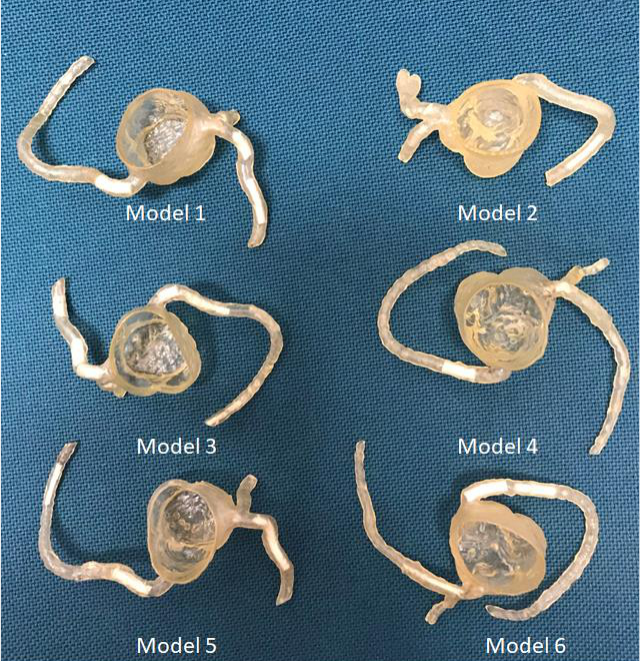
Figure 9. Creation of simulated calcified plaques. ( A ): Different material compositions to simulate calcification in the 3D-printed mould. ( B ): CT image of these materials with measured CT attenuation being 450 HU, 600 HU, 900 HU and 800 HU, corresponding to silicone, silicone + 3% ethiodized oil, silicone + 5% ethiodoized oil and silicone + 32.8% calcium carbonate, respectively. The combination of silicone + 32.8% calcium carbonate was selected to produce 800 HU attenuation, representing highly calcified plaques. Reprinted with permission under the open access from Sun et al. [53].